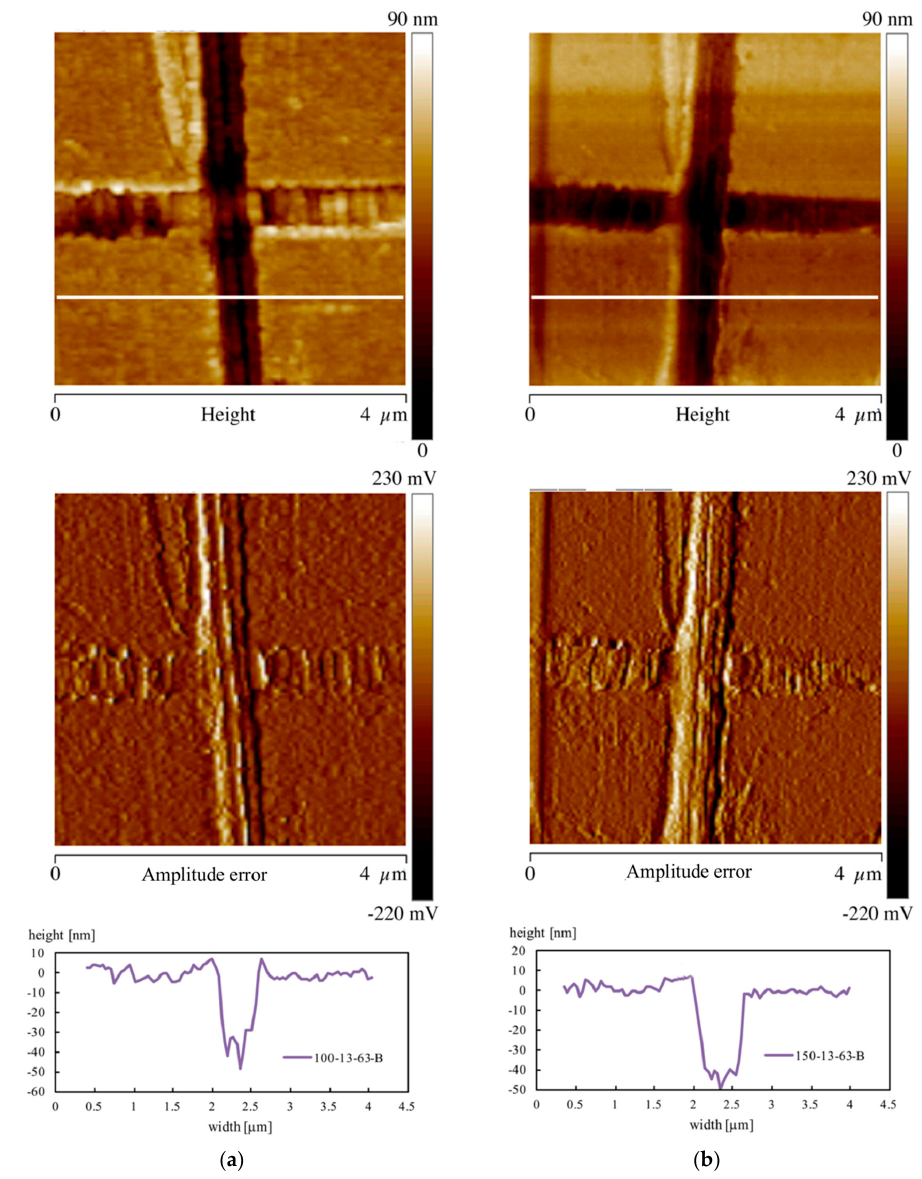
Figure 12. Height and amplitude error AFM maps of the samples ( a ) 100-13-63-B and ( b ) 150-13-63-B. The pattern related to the white line reported in the height map is also shown. The pattern related to the white line reported in the height map is also